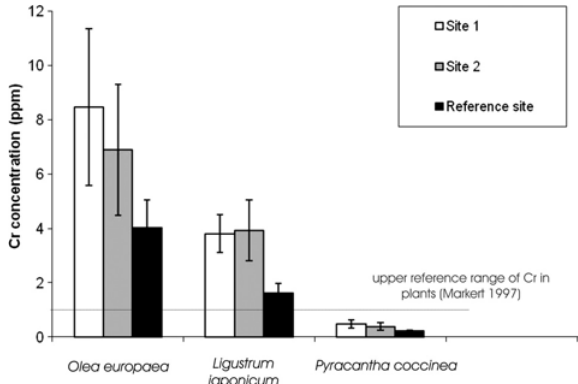
Fig. 6. Lead concentrations (ppm dry wt) in the leaves of Olea europaea , Ligustrum japonicum, and Pyracantha coccinea from different studied sites (site 1: industry; site 2: traffic; reference site: botanical